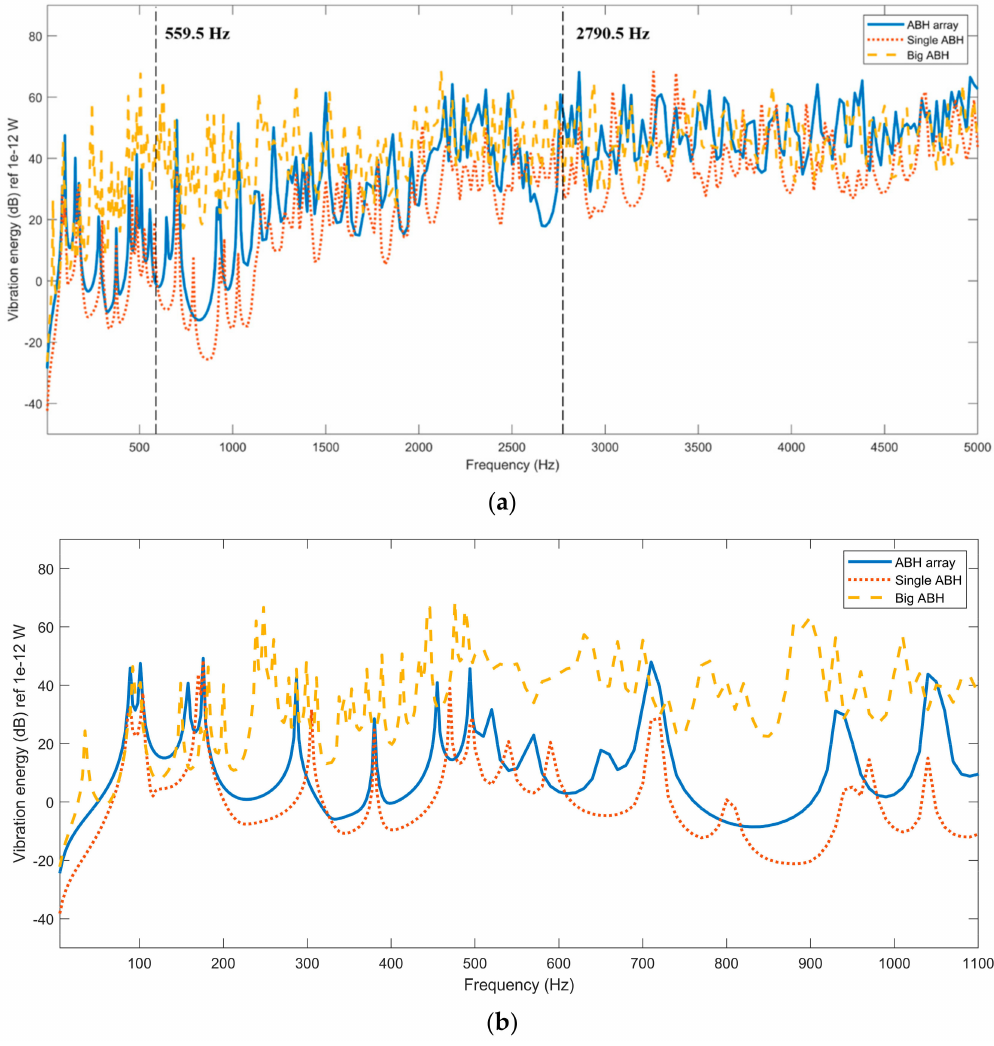
Figure 4. Vibration energy comparison among three ABH plate configurations. ( a ) 5–5000 Hz, ( b ) 5–1050